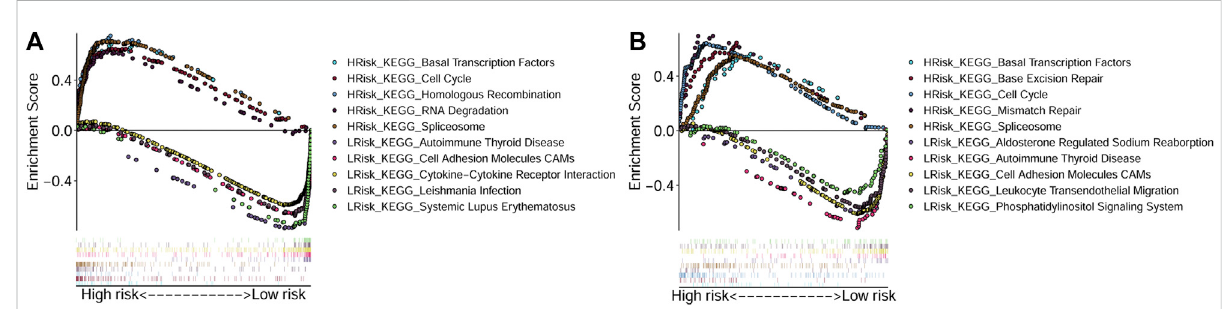
FIGURE 4 Gene Set Enrichment Analyses based on the conducted signature. (A) Active pathways inthe HRisk and LRisk groups in TCGA cohort. (B) Active pathways in the HRisk and LRisk groups in GEO cohort. GEO: The Gene Expression Omnibus, TCGA, The Cancer Genome Atlas, HRisk, high-risk, LRisk,